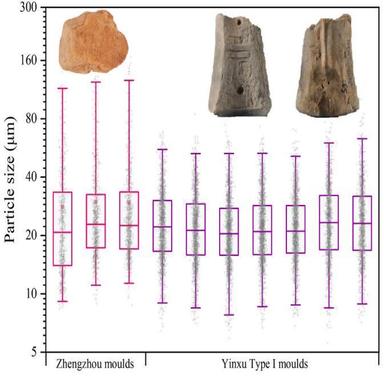
The comparison of particle size between the Early and Late Shang moulds.